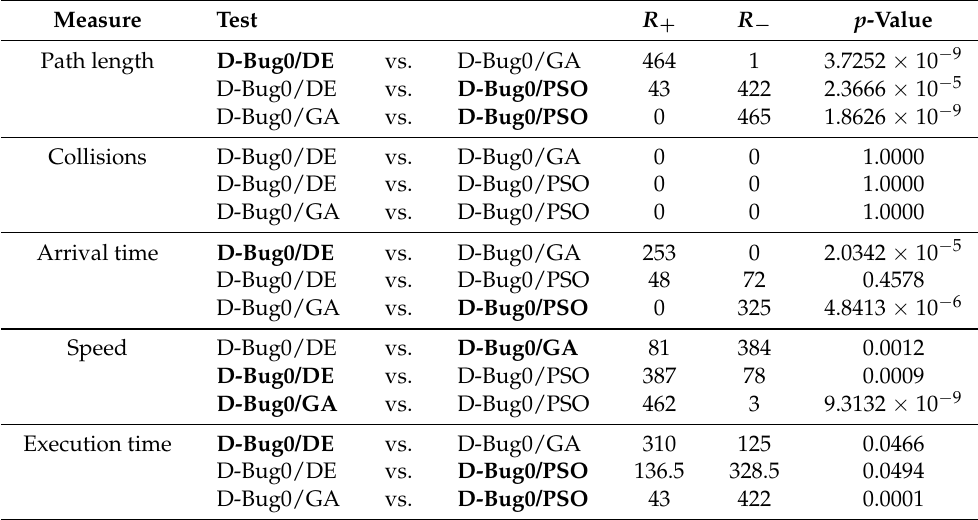
Table 3. Pairwise Wilcoxon tests over the results of the 30 independent executions with D-Bug0/DE, D-Bug0/GA, and D-Bug0/PSO.